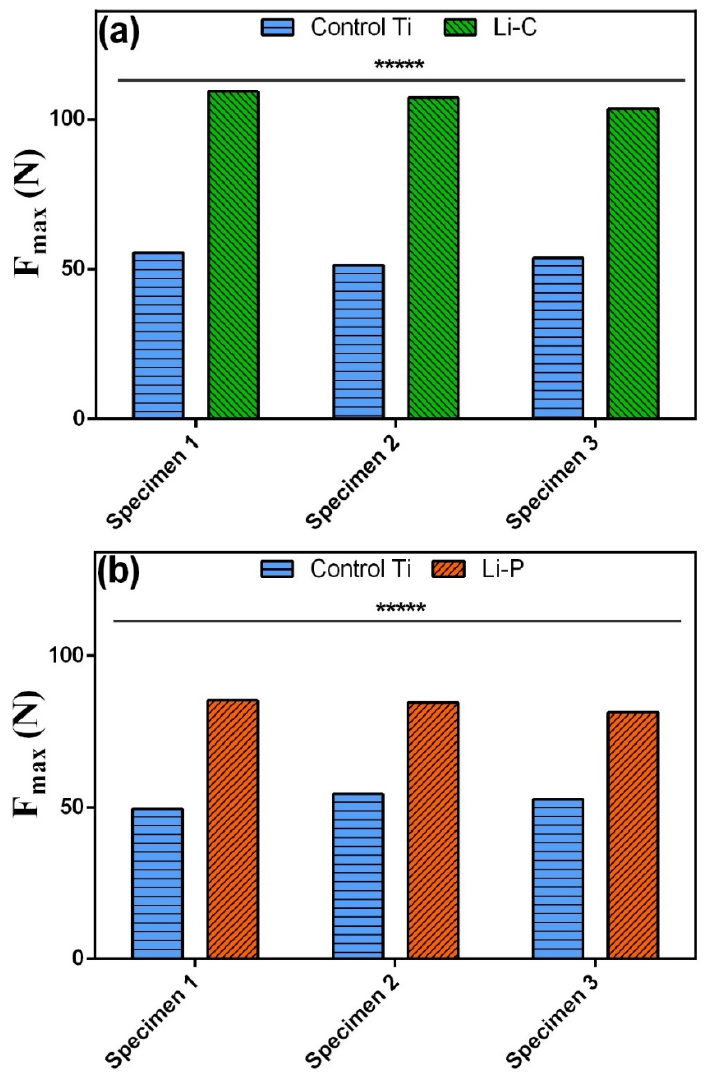
Figure 7. Detachment force, F max , of implants ( n = 3) under tensile pull-out testing, inferred in the case of control 3D Ti implants (marked in blue color) and of those functionalized with ( a ) Li-C (marked in green color) and ( b ) Li-P (marked in orange color) coatings, at 9 weeks after surgery. ***** Represents highly significant differences ( p ≤ 0.00001).